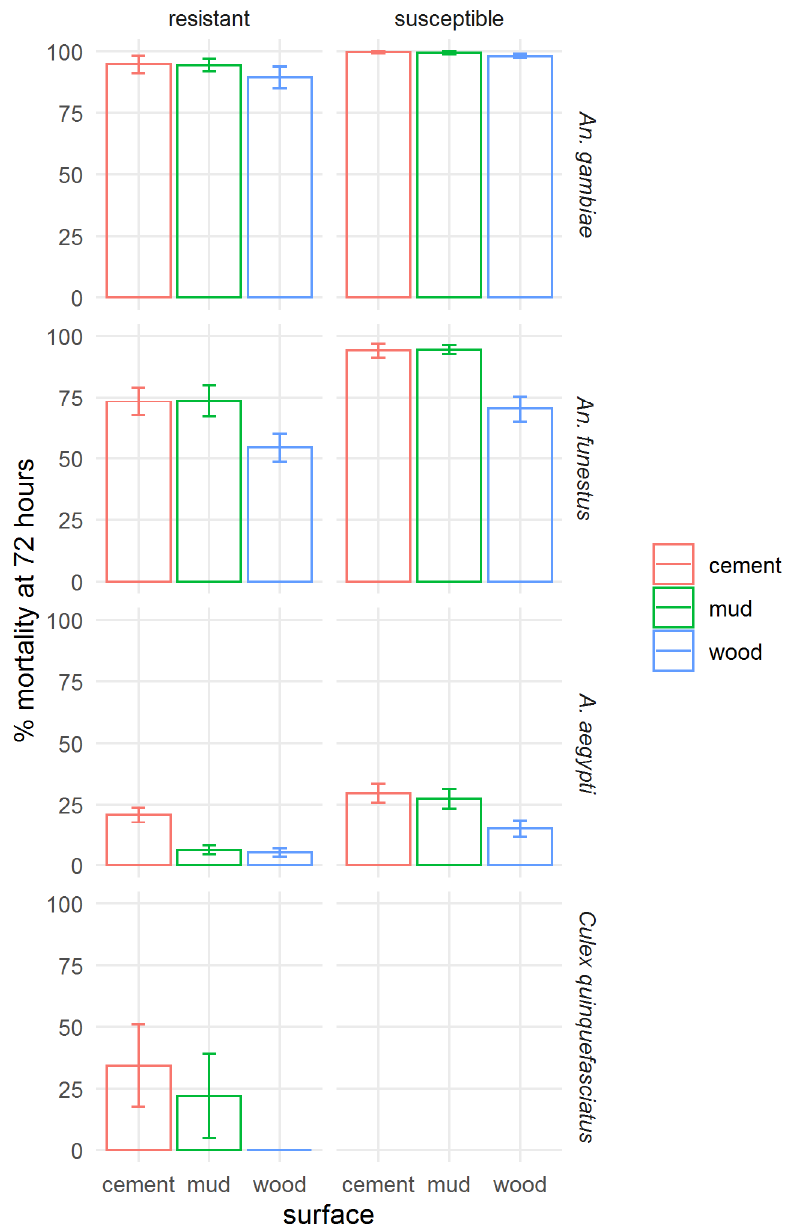
Figure 7. Effect of surface type on the efficacy of SumiShield™ 50WG. Mortality of insecticide susceptible and resistant Anopheles gambiae , An. funestus , and Aedes aegypti , and resistant Culex quinquefasciatus . Average 72 h mortality calculated across all replicate bioassays at all time points (0, 1, 3, 5, 7, 9, 12, and 18 months) for each strain and surface type is shown; error bars represent standard error across 3 replicate assays.